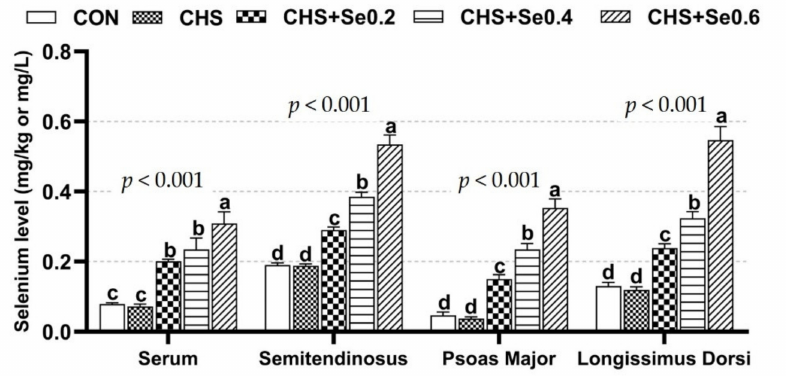
Figure 3. Se concentration in serum and muscle. The results were expressed as Mean ± SEM ( n = 6). Different alphabet letters (a, b, c, d) denote significant differences ( p <